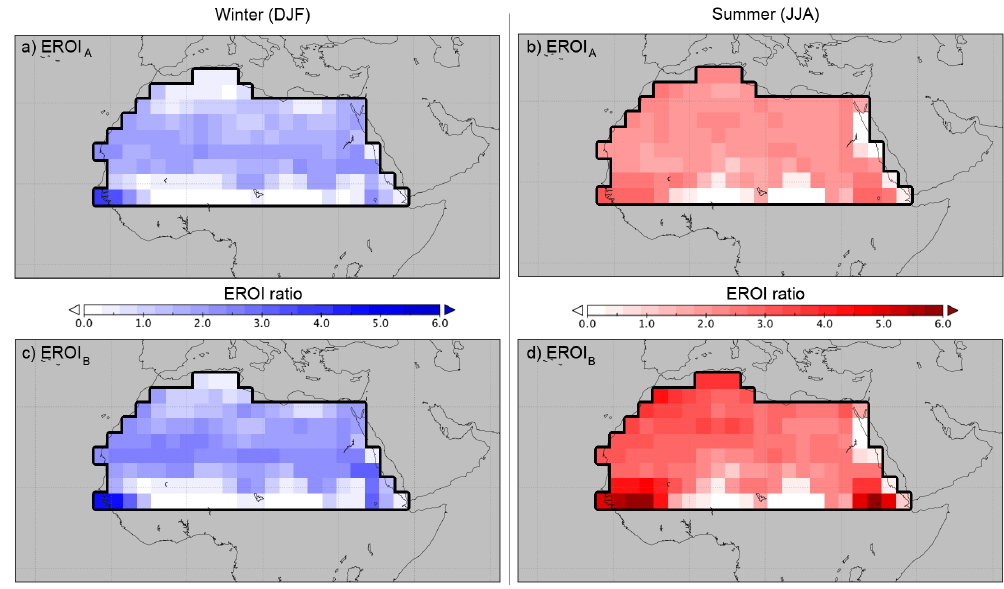
Fig. 3. Seasonal mean EROI A (a, b) and EROI B (c,d) over the irrigated region in DJF (a, c) and JJA (b, d) . Winter values are taken from the 700mmyr − 1 simulations, while summer values are taken from the 1000mmyr − 1 simulations. The black solid line shows the outer bounds of the irrigated